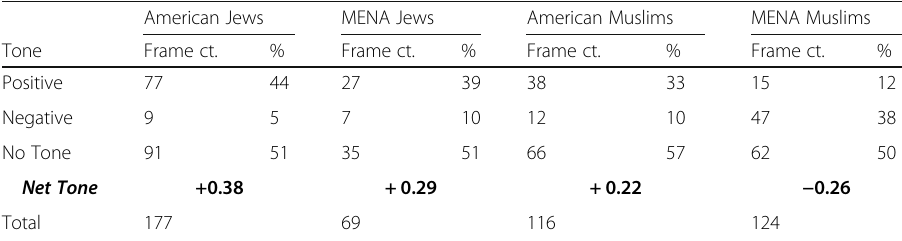
Table 7 New York Times Net Tone – Domestic &